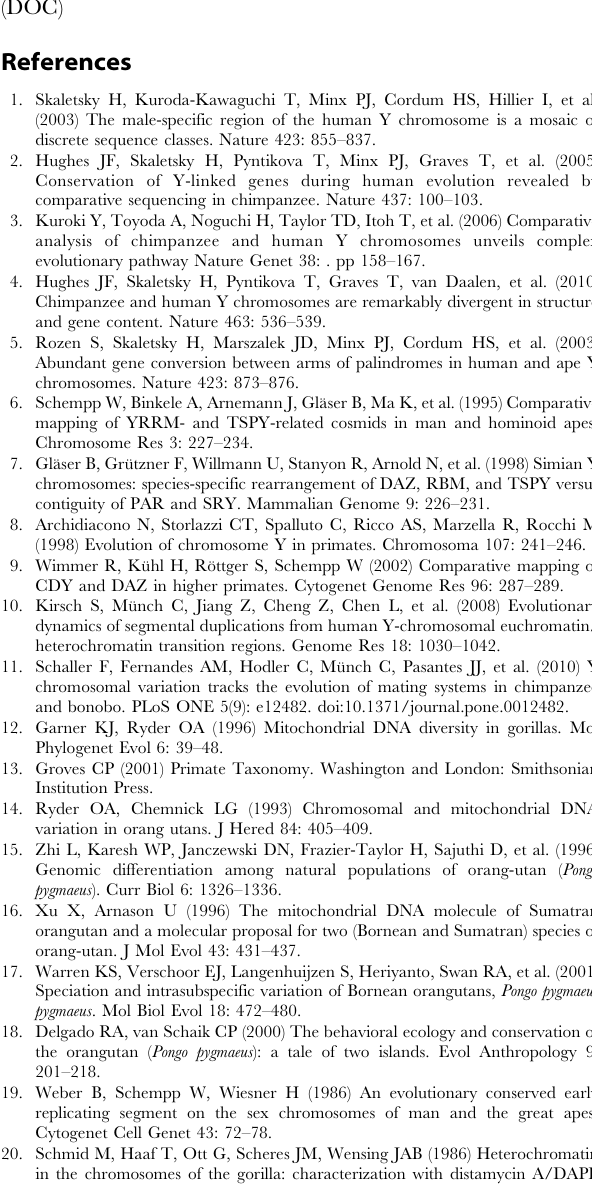
Table S1 Gorilla specimens. Table S2 Bornean orangutan ( Pongo pygmaeus ) specimens. Table S3 Sumatran orangutan ( Pongo abelii ) specimens. Table S4 Common chimpanzee – qPCR calculated data. (XLS) Table S5 Bonobo – qPCR calculated data. Table S6 Bonobo – qPCR and FISH for DAZ & CDY.